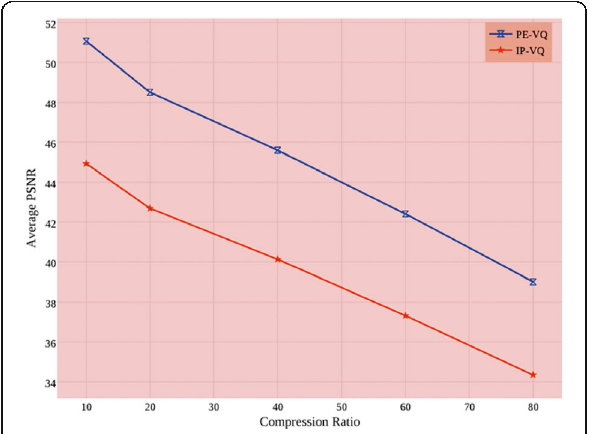
Fig. 14 Comparison of PE-VQ and IP-VQ methods for DB2 with ECB =